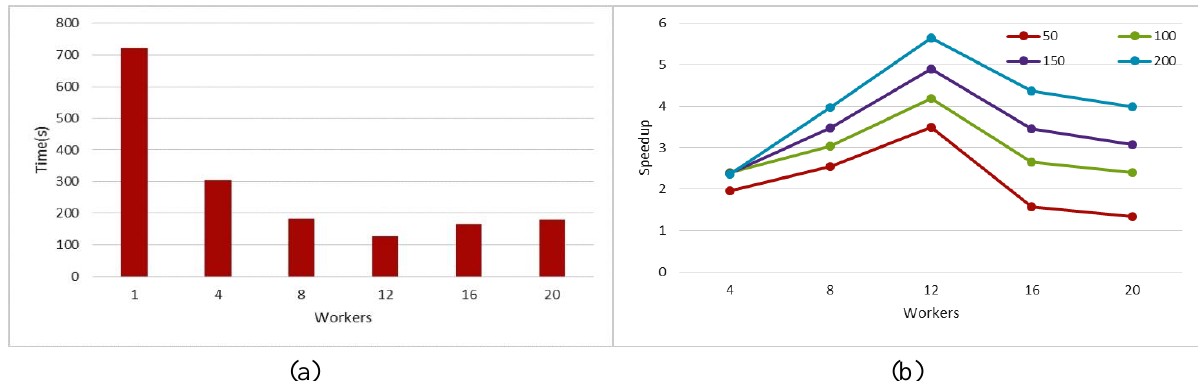
Figure 8. Time taken to run Job 1 on 200 images with different numbers of cores (workers) (a). Speed-up with different number of images (50, 100, 150, 200) on Job 1 (b).